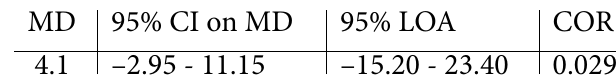
Table 2 . The mean difference (MD) between the two sets of osmolarity data, 95% limits of agreement (LOA) and the coefficient of reproducibility (COR) are shown. Included is the confidence interval on the MD (CI). The COR has no units while all other metrics have units of mOsms/L.